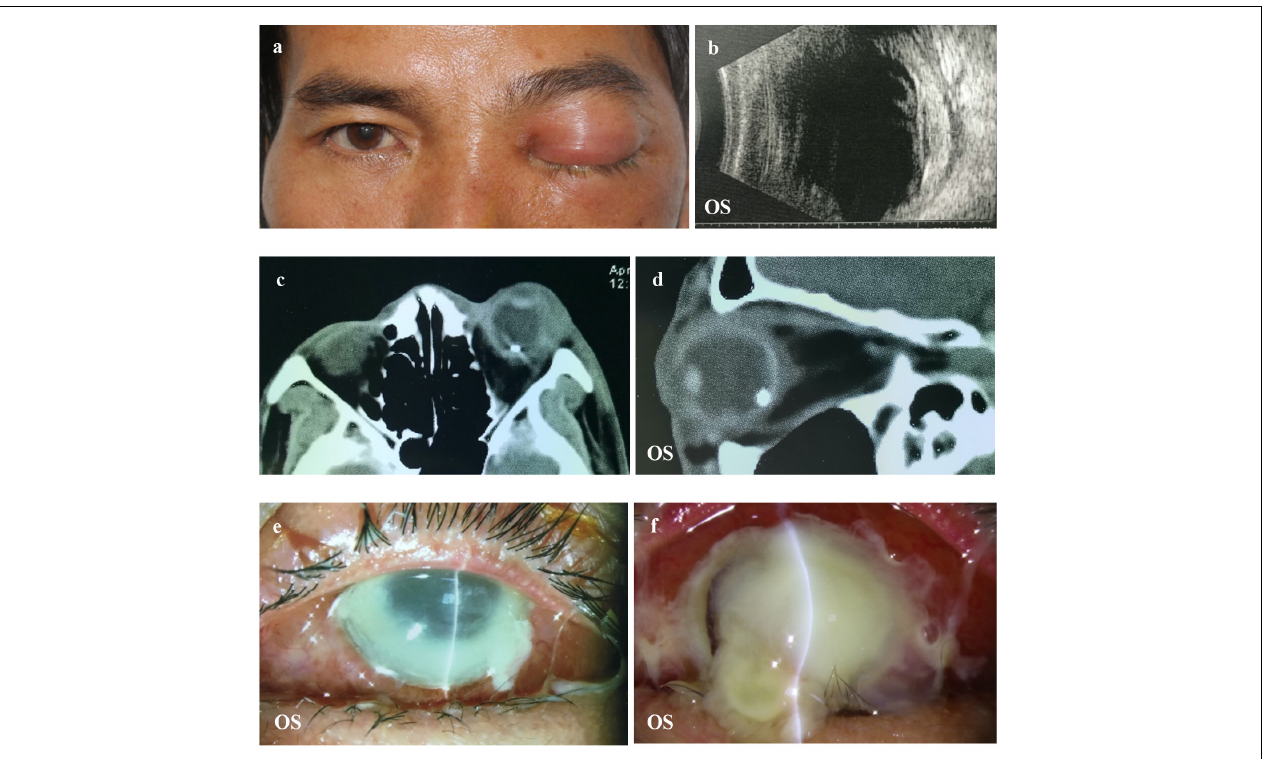
FIGURE 1 | Representative image of a patient with OC. (a,b) The patient complained of vision loss and orbital pain 1 day after a foreign body splashed into the left eye. B-scan showed increased choroidal thickness. (c,d) CT showing inflammation of the orbital tissue and IOFB in the left eye. (e,f) Uncontrolled total corneal melting that required an evisceration. OC, orbital cellulitis; CT, computed tomography; IOFB, intraocular foreign